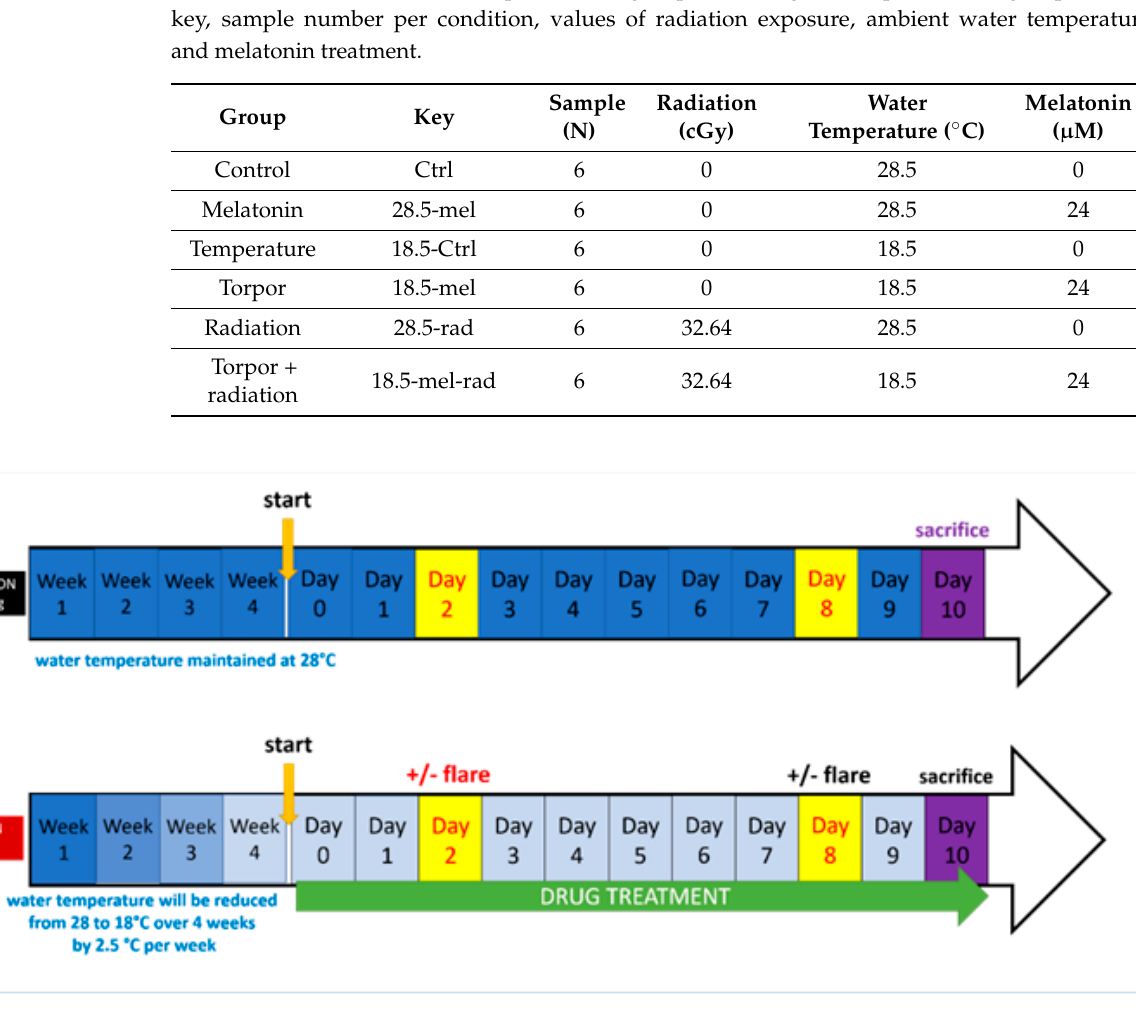
Figure 1. Experiment timeline shows the radiation group ( top ) maintained at 28.5 °C, receiving radiation on the 2nd and 8th day prior to sacrifice on the 10th day. The torpor + radiation group ( bottom ) was lower temperature acclimatised over 4 weeks, when 18.5 °C was reached they also received 24 µM of melatonin daily for 10 days. Radiation exposure was administered on the 2nd and 10th day prior to sacrifice on the 10th day.